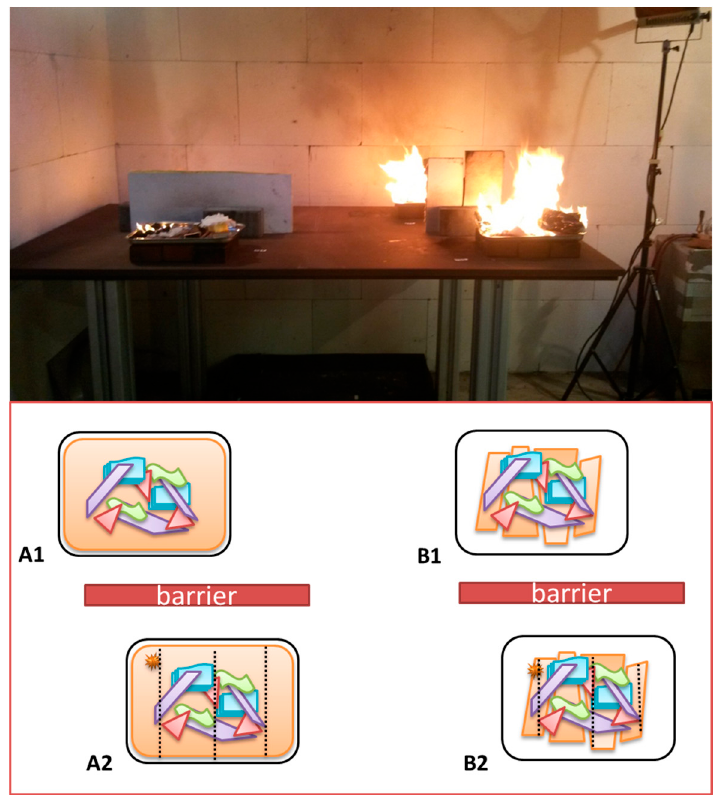
Figure 2. Schematic representation of the positioning of the different grill plates on the steel table and a photograph of a typical fire experiment. On the left two plates of substrate combination ( A ), ( A1 ) is the blank and ( A2 ) has IL added. On the right two plates of substrate combination ( B ), ( B1 ) is blank and ( B2 ) with IL added.